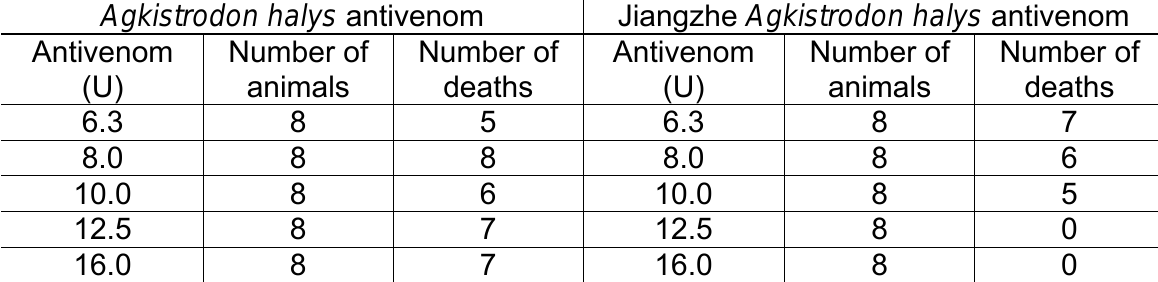
Table 5.2: Anti-lethal toxin effective dose (ED Agkistrodon halys antivenoms against 107.3 µg Jiangzhe Agkistrodon halys venom (3.7 x LD ) intraperitoneally injected into mice. 50